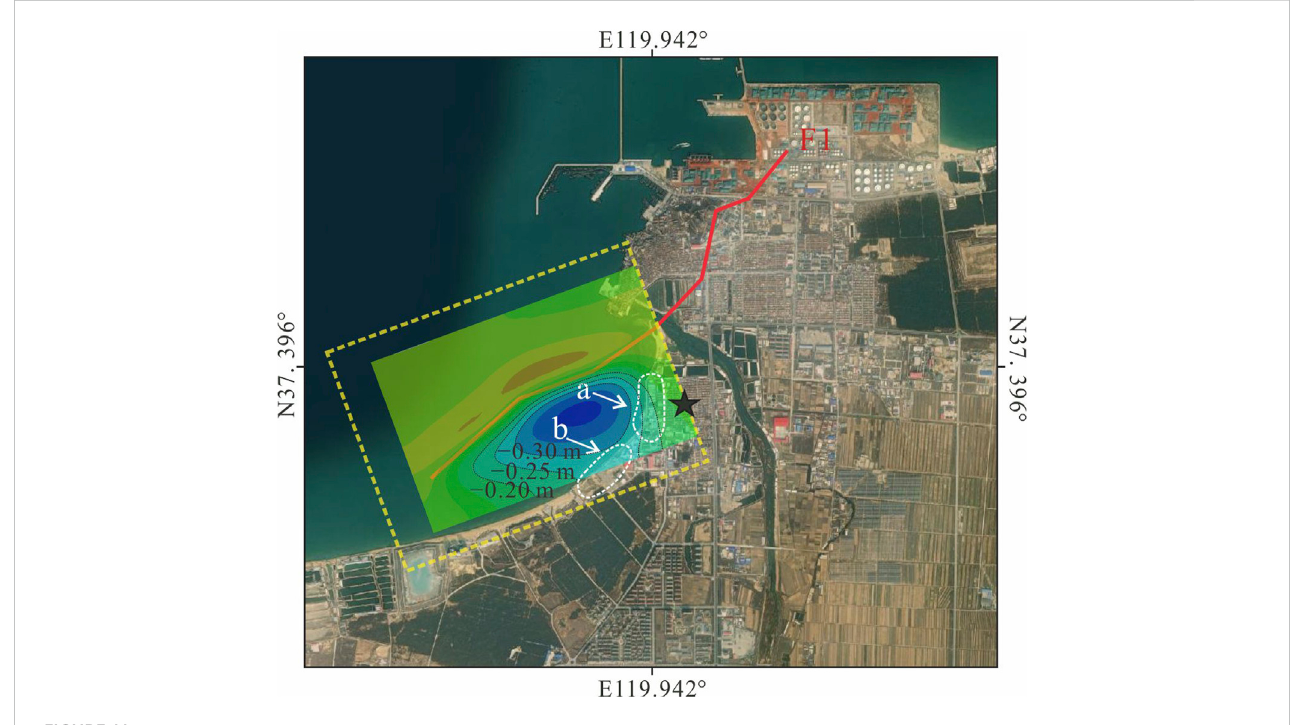
FIGURE 11 Result of superimposing the subsidence contour plot onto the